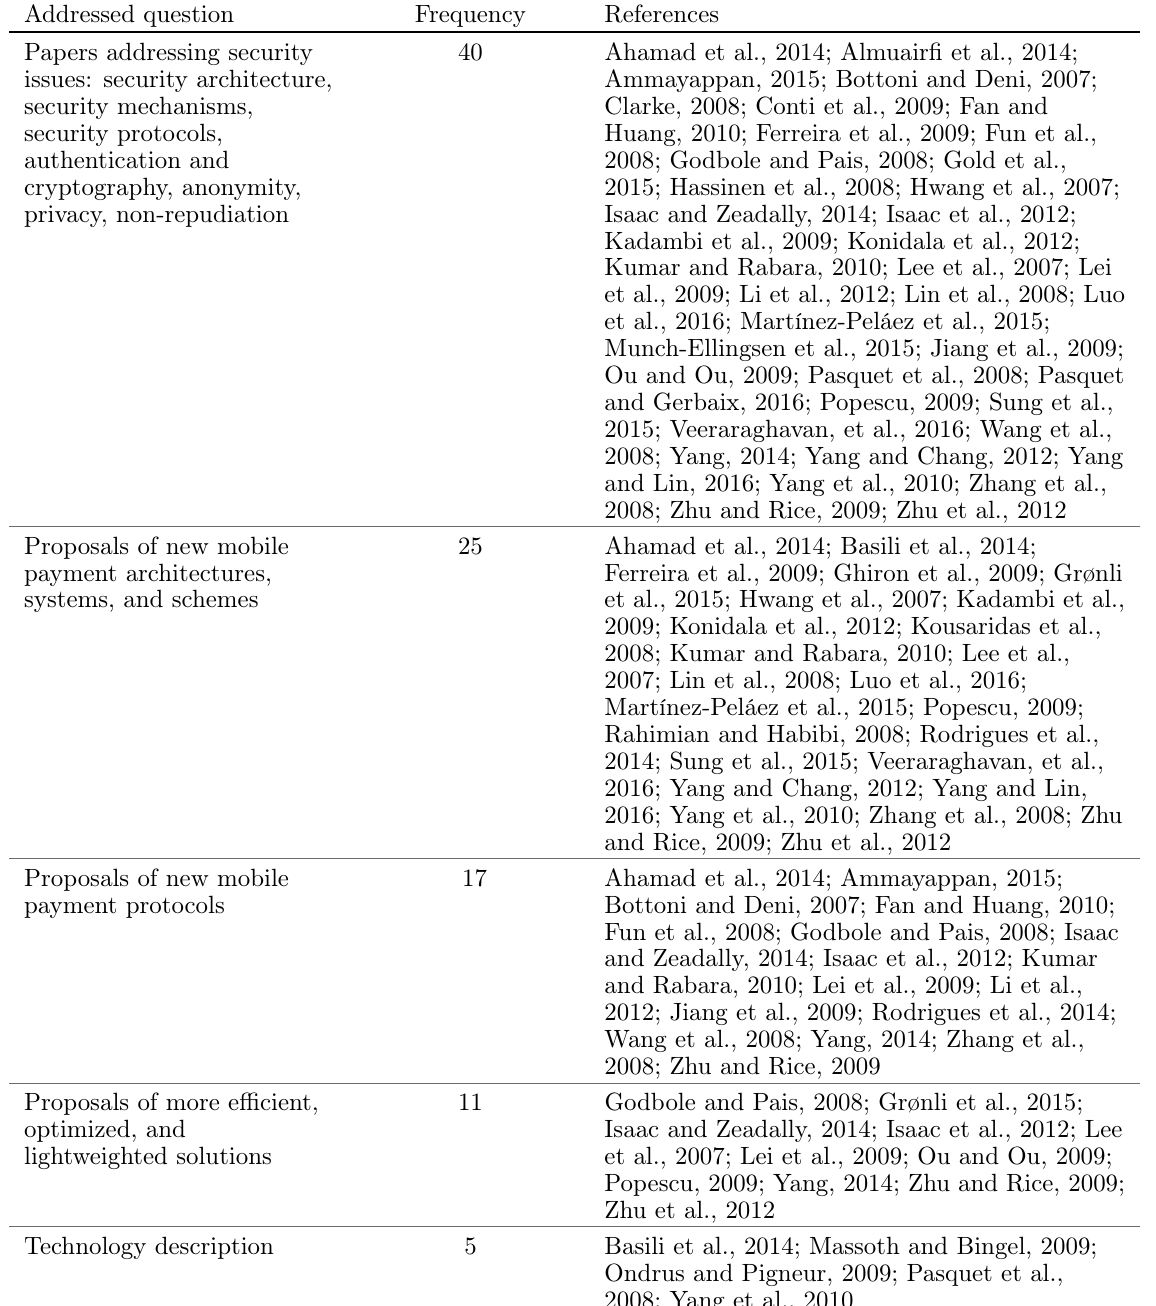
Table D.1. Classification of papers on technology by